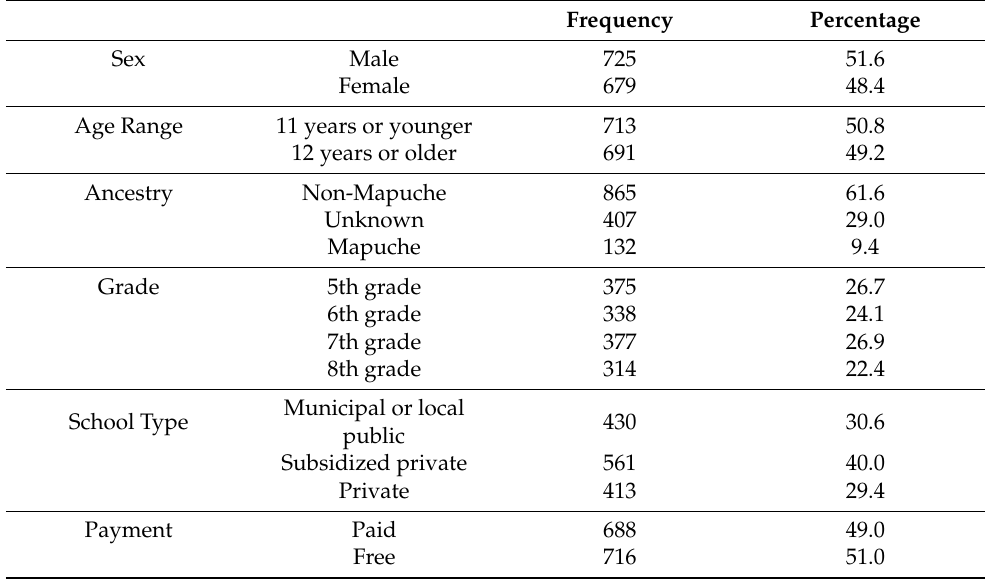
Table 1. Characteristics of the participants. Source: prepared by the authors.